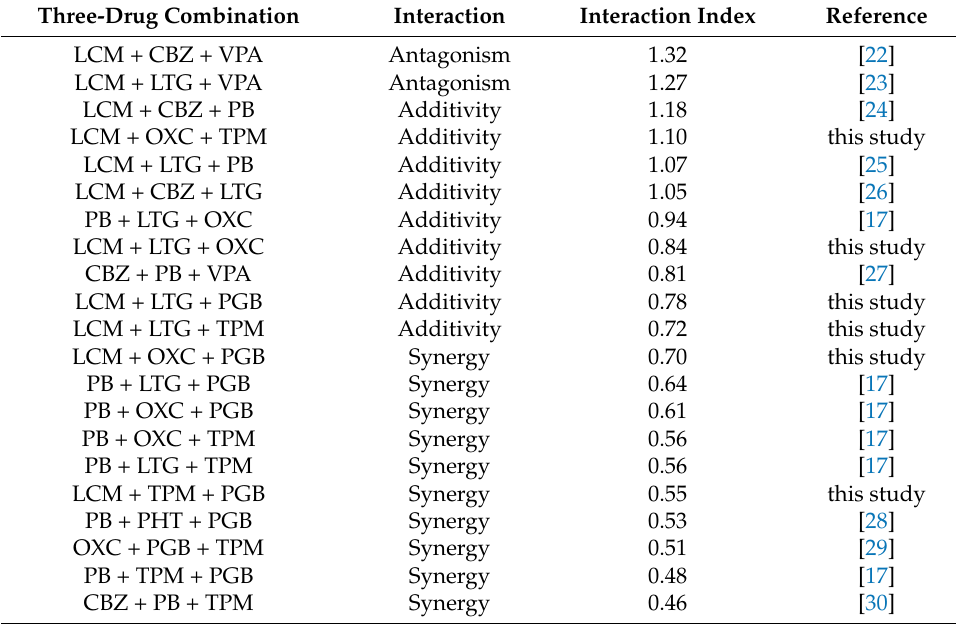
Table 2. Characteristics of interactions for triple combinations of